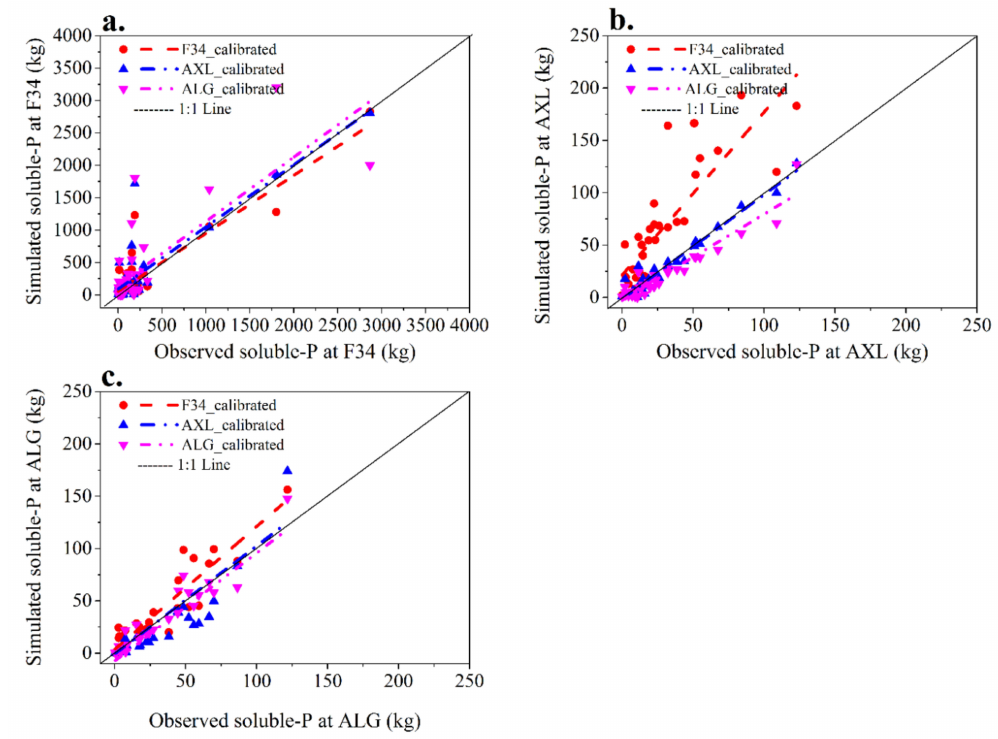
Figure 5. One-to-one plots of SWAT simulated vs. observed monthly soluble P loads at the ( a ) F34 watershed outlet, ( b ) AXL watershed outlet, and ( c ) ALG watershed outlet for the calibration period from January 2006 to December